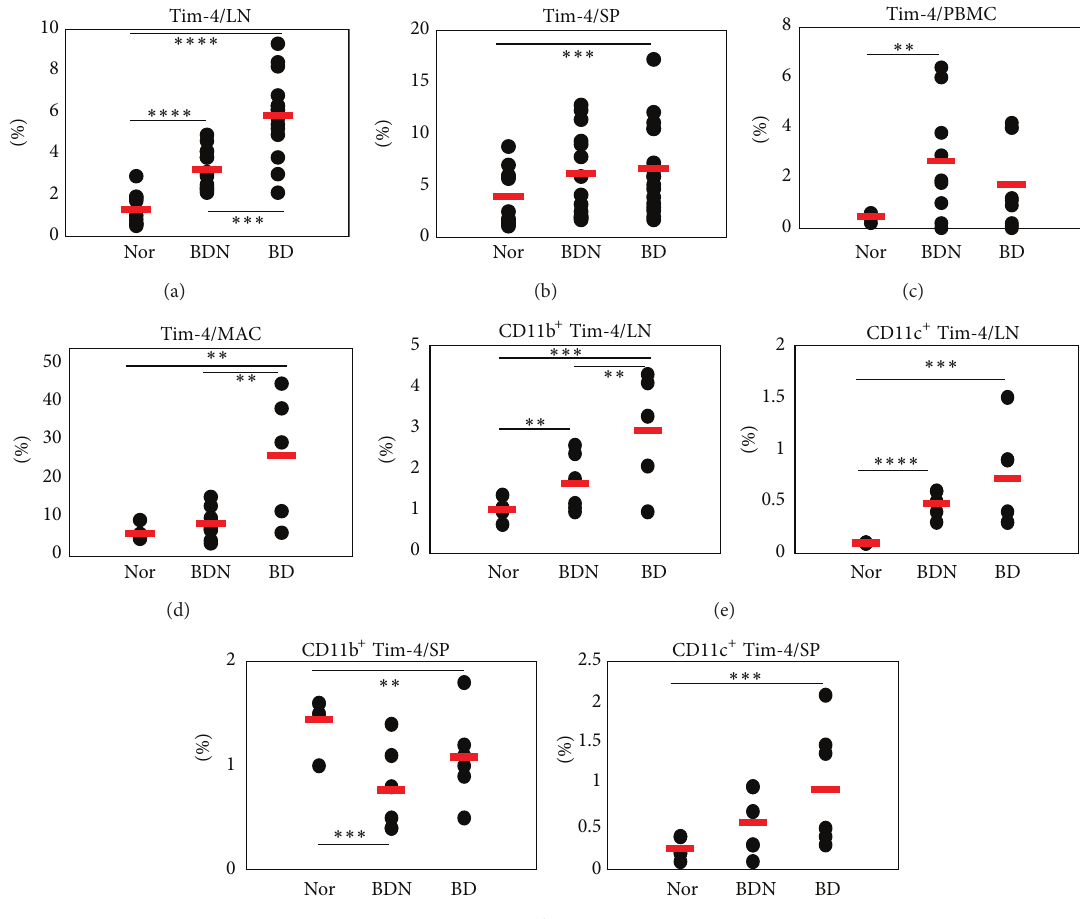
Figure 2: The frequencies of Tim-4 + cell phenotypes in normal healthy, BDN and Behc¸et’s disease (BD) mice. The frequencies of Tim-4 +